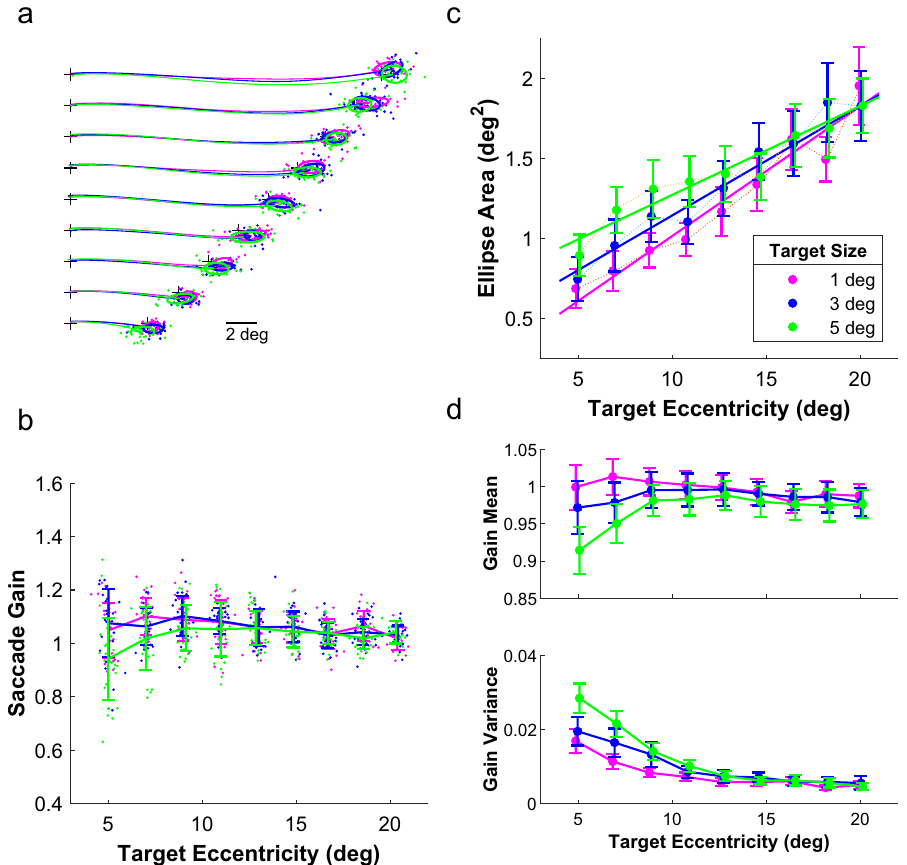
Figure 1. Endpoint variability. ( a ) Individual dots show the endpoints of the saccades made to the different target locations and different target sizes (color coded) by one of our subjects. The lines represent the average saccade trajectories from the fixation point (+) to the peripheral targets. The ellipses represent the distributions of the endpoints. Only rightward saccades of the subject’s right eye are shown. ( b ) Amplitude gain of the same rightward saccades as a function of target eccentricity. A gain of 1 corresponds to a saccade that lands at the center of the briefly (100 ms) flashed target. Solid lines indicate the mean, error bars indicate ± 1 standard deviation. ( c ) Effect of target eccentricity and target size on endpoint variability. Larger ellipse areas reflect more scatter among the endpoints. The solid lines are the result of a mixed effects model fitted to all data (both eyes and both target directions) from all subjects. Dashed lines are grand averages from all 8 subjects. Error bars indicate ± 1 standard deviation of the grand means. ( d ) Grand mean of the saccade gain and the grand mean of the gain variance for different target eccentricities. Error bars indicate ± 1 standard deviation of the grand